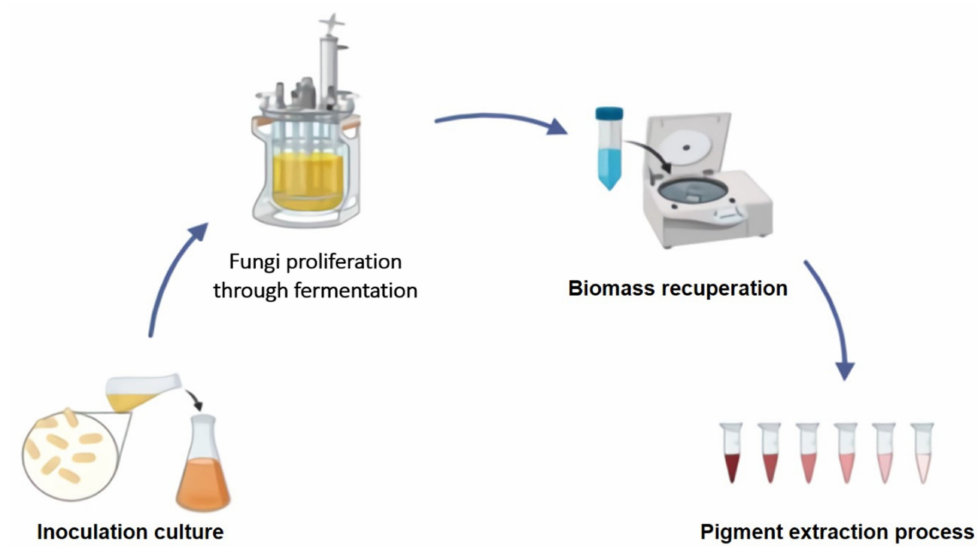
Figure 1. A general scheme for the production of fungal pigments under established controlled